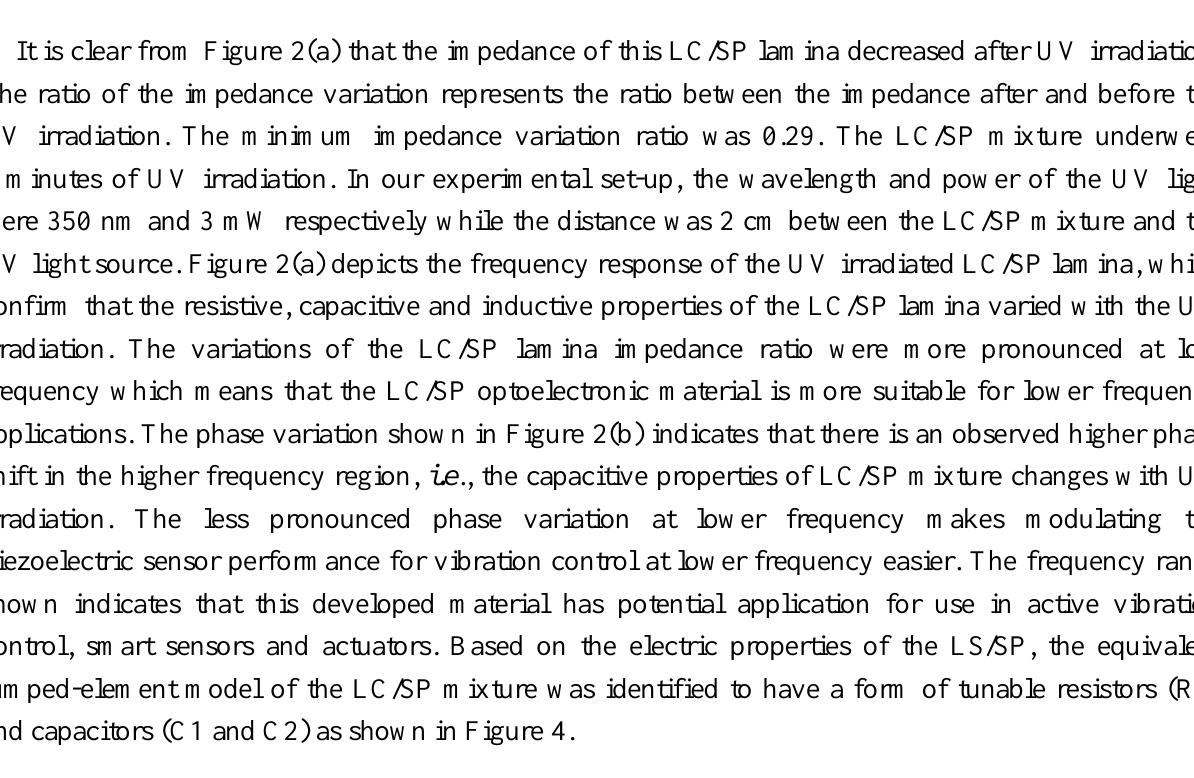
Figure 4. Equivalent lumped-element model of the LC/SP mixture composed of resistor (R1) and capacitors (C1, and C2). The tunable range of R1, C1 and C2 were calculated from the impedance measurement results treated without and with UV